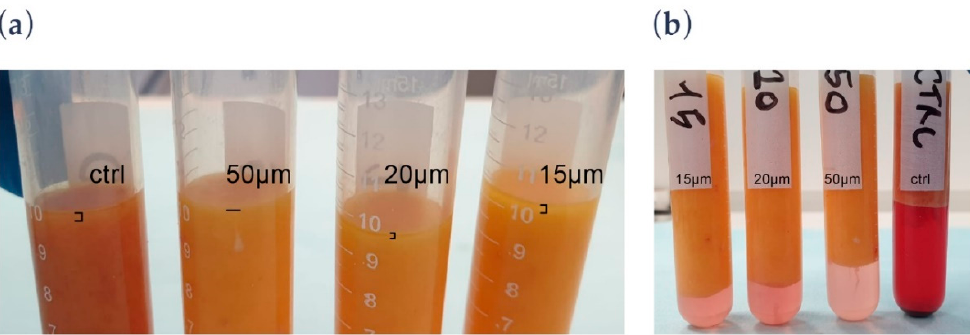
Figure 2. ( a ) Qualitative picture showing centrifuged samples with a focus on the heavier phase. ( b ) Qualitative picture showing of centrifuged samples with a focus on the lighter phase.